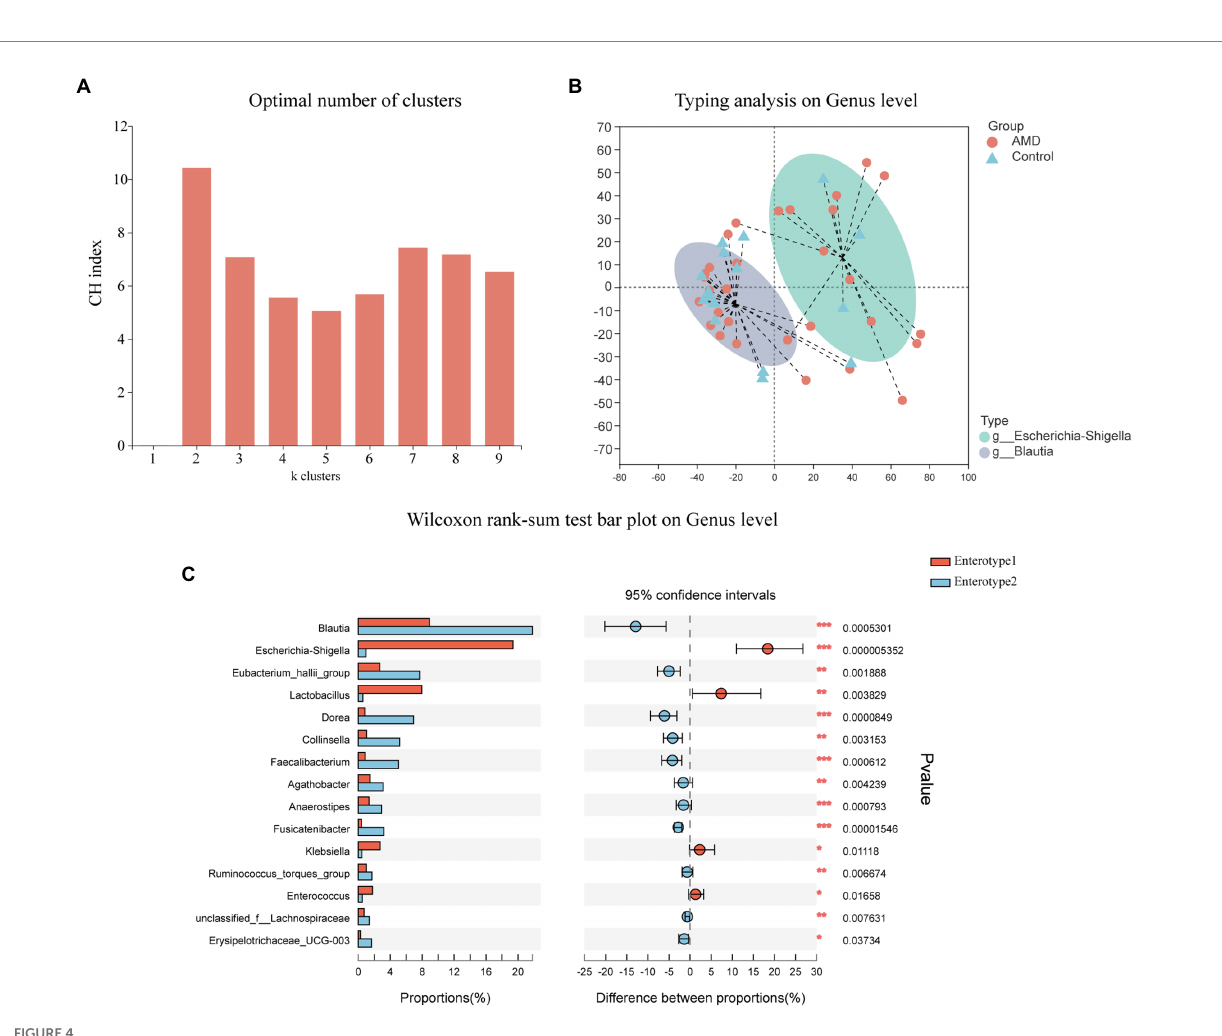
FIGURE 4 Enterotypes of the intestinal microbiome in AMD patients and healthy controls using Jensen-Shannon distance. (A) The optimal number of enterotypes was two as indicated by the maximum CH index at two clusters. (B) The figure showed the clustering on the first two principal components. Patients ( n = 30) and controls ( n = 17) were denoted by circles and triangles, respectively. (C) Comparison between the two enterotypes at the genus